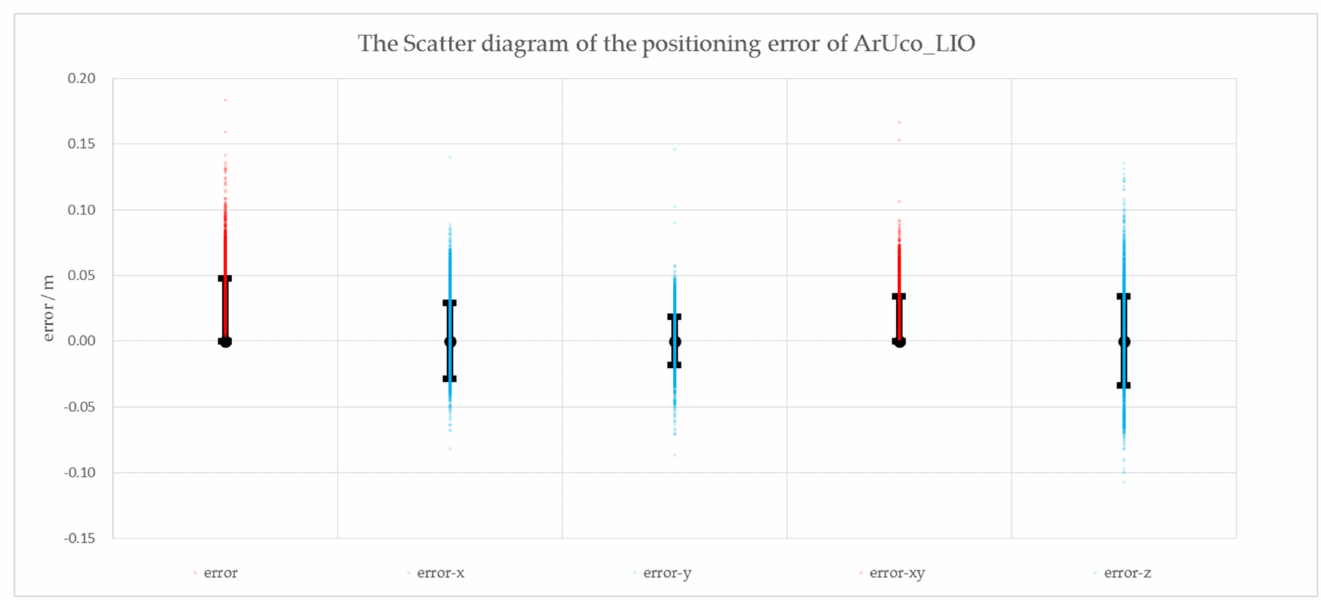
Figure 16. The Scatter diagram of the positioning error of